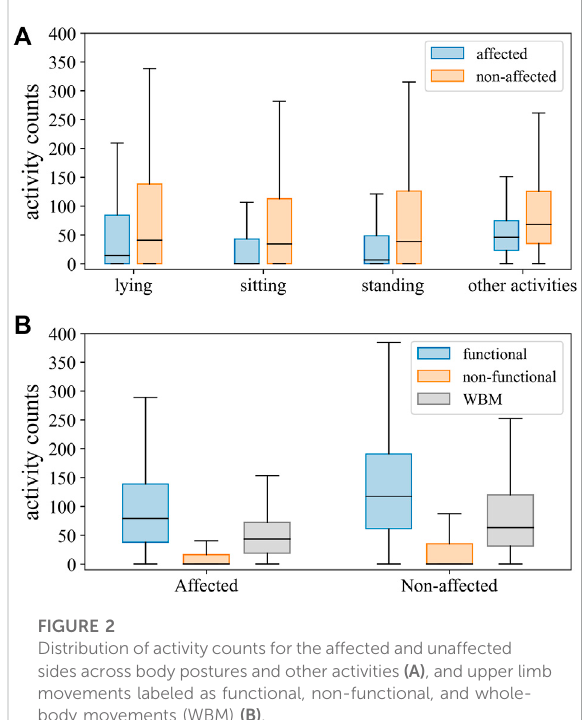
FIGURE 2 Distribution of activity counts for the affected and unaffected sides across body postures and other activities (A) , and upper limb movements labeled as functional, non-functional, and whole- body movements (WBM) (B)